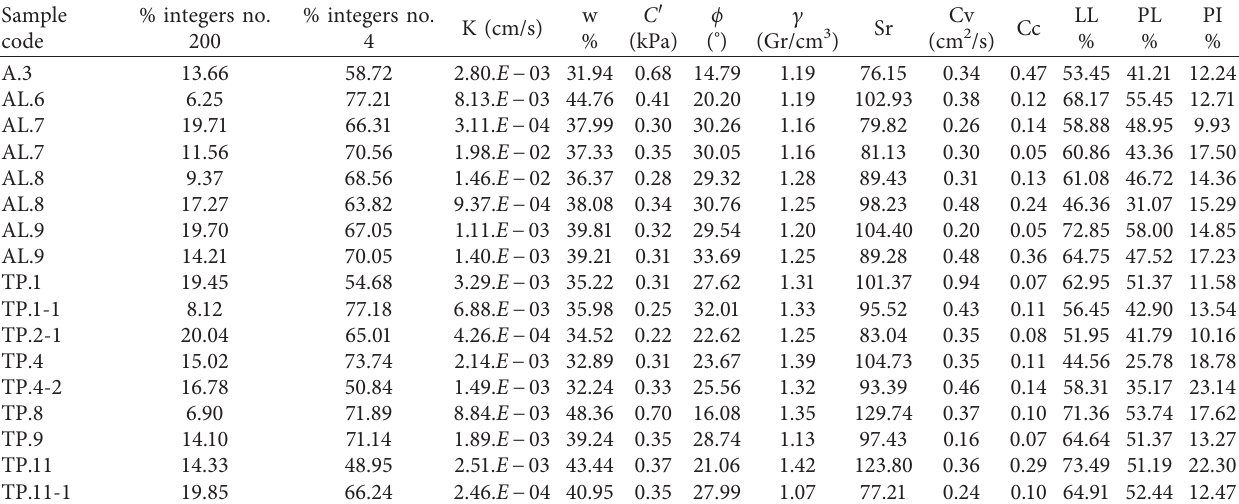
Table 2: Indexes properties of